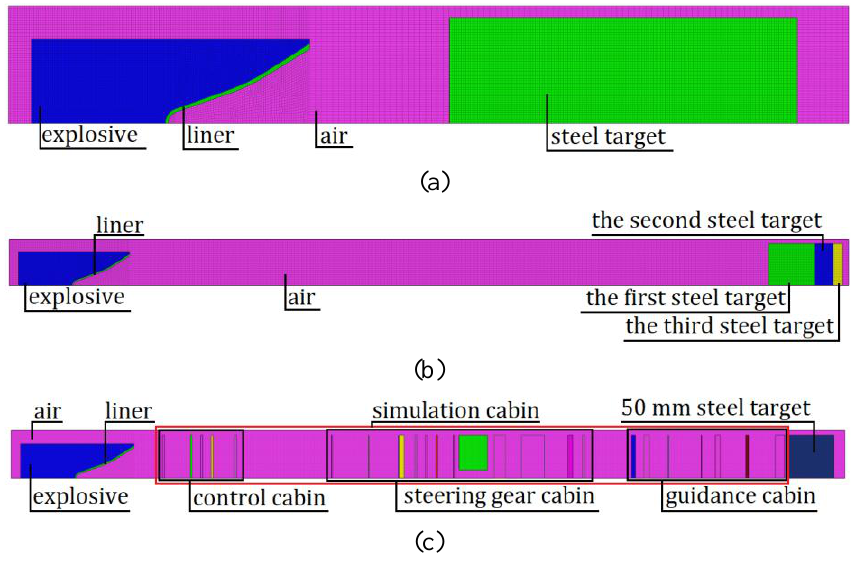
Figure 5. Finite element model: ( a ) of striking plate, ( b ) without simulation cabin, and ( c ) with the simulation cabin.